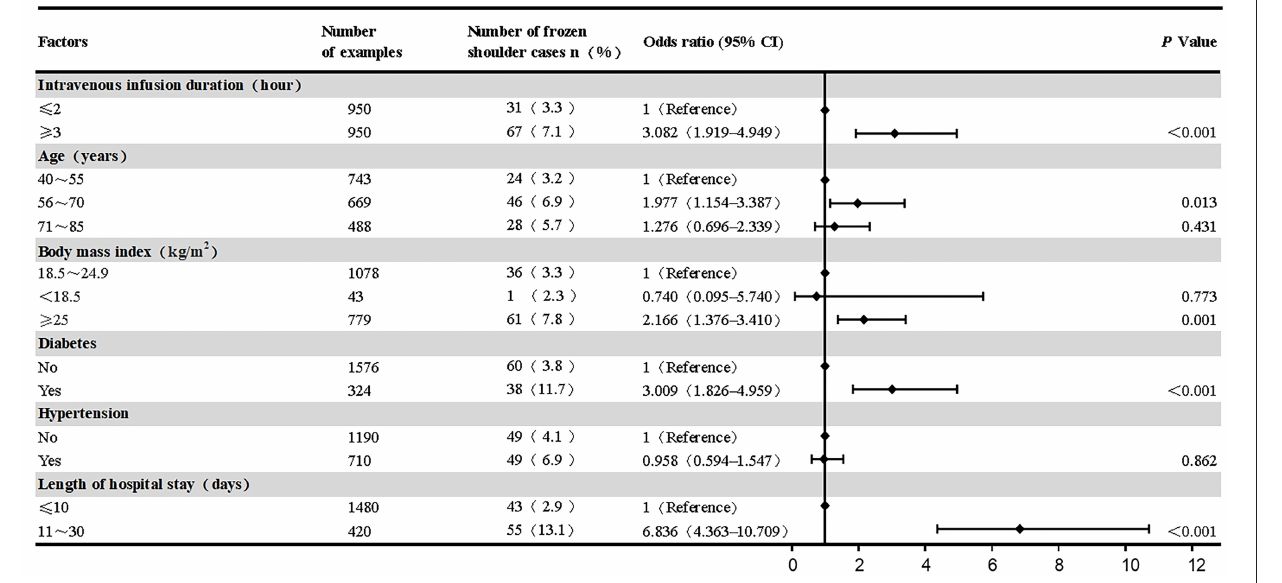
FIGURE 4 | Multivariate binary logistic regression analysis on the risk of frozen shoulder in study